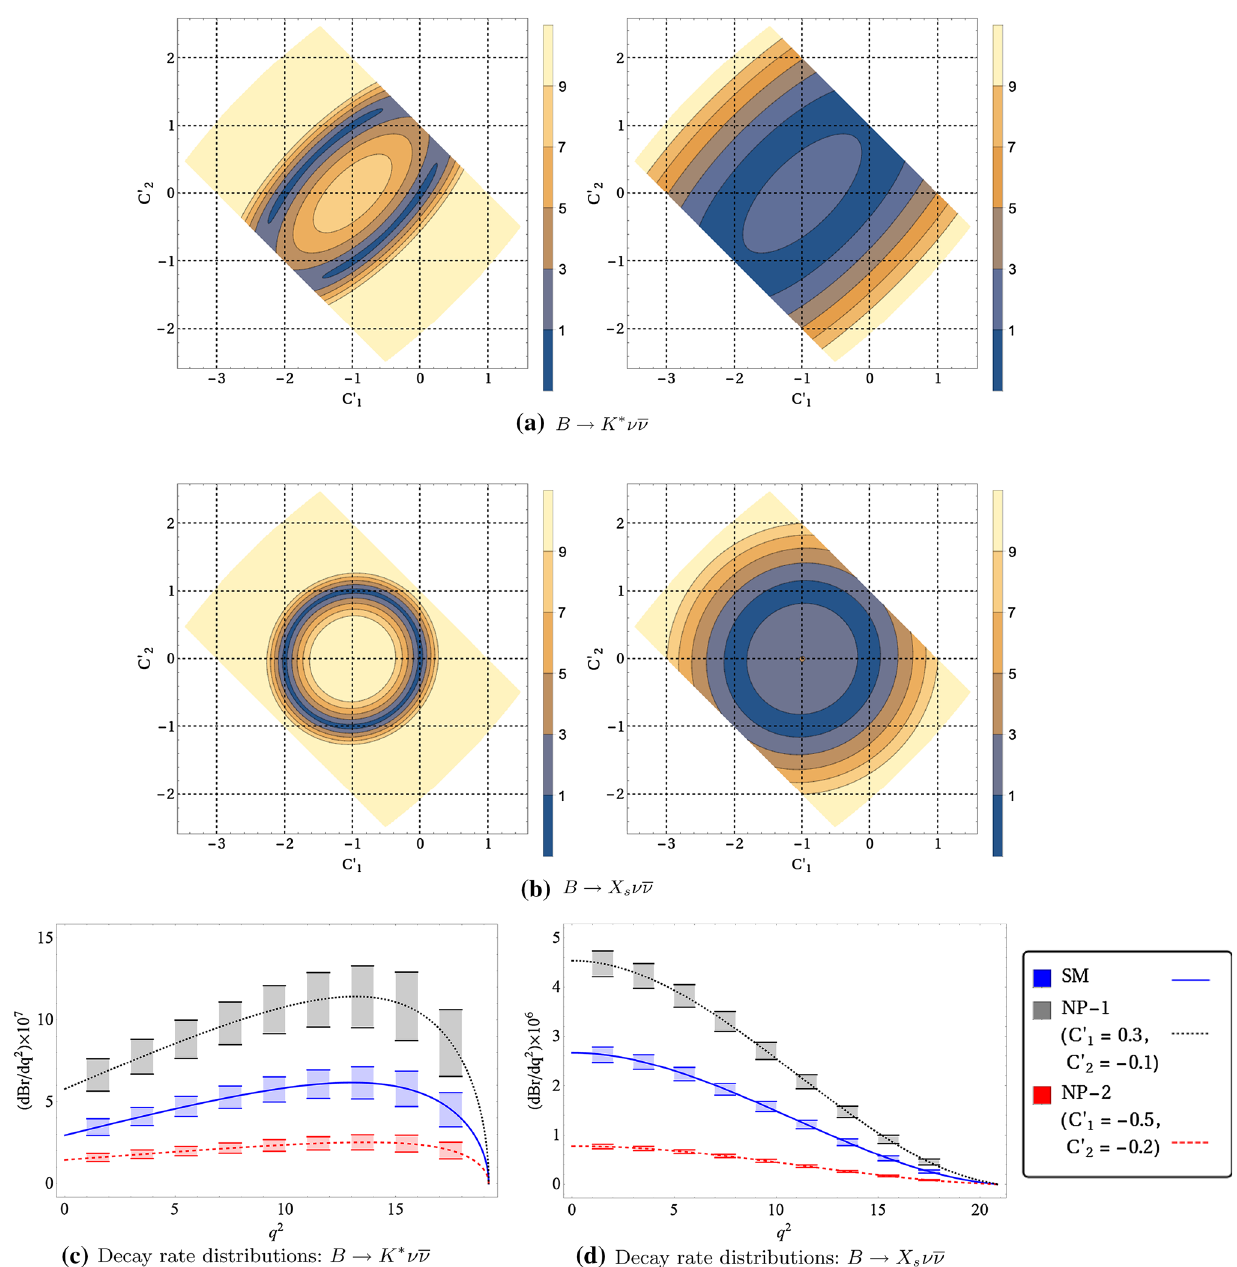
Fig. 3 ( a ) and ( b ) The SM-NP differentiating χ 2 contours for the exclusive and the inclusive channels coming from b → s ν ¯ ν , where the left and the right panels are for L int = 50ab − 1 and 2 ab − 1 , respec- tively. The q 2 (in GeV 2 ) distributions of the decay rates are shown in c